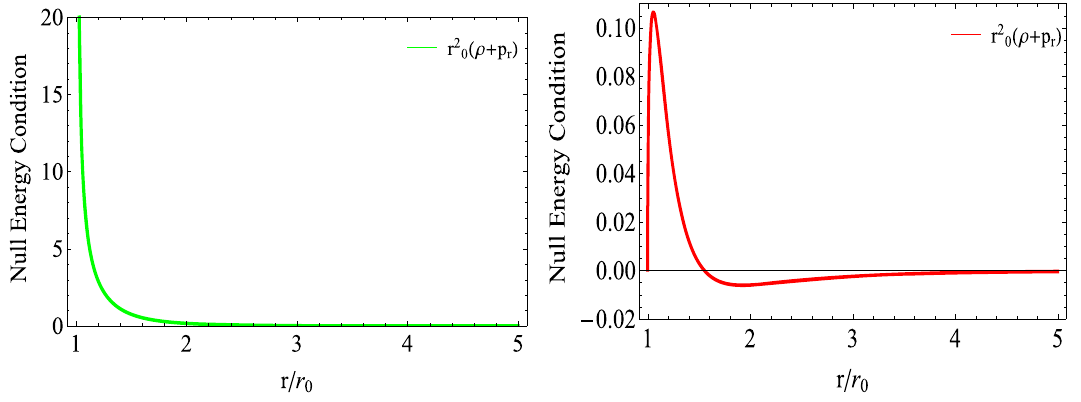
Fig. 4 The dimensionless null energy condition against the dimensionless radial coordinate r / r 0 for m = 1 (left panel) and m = 0 (right